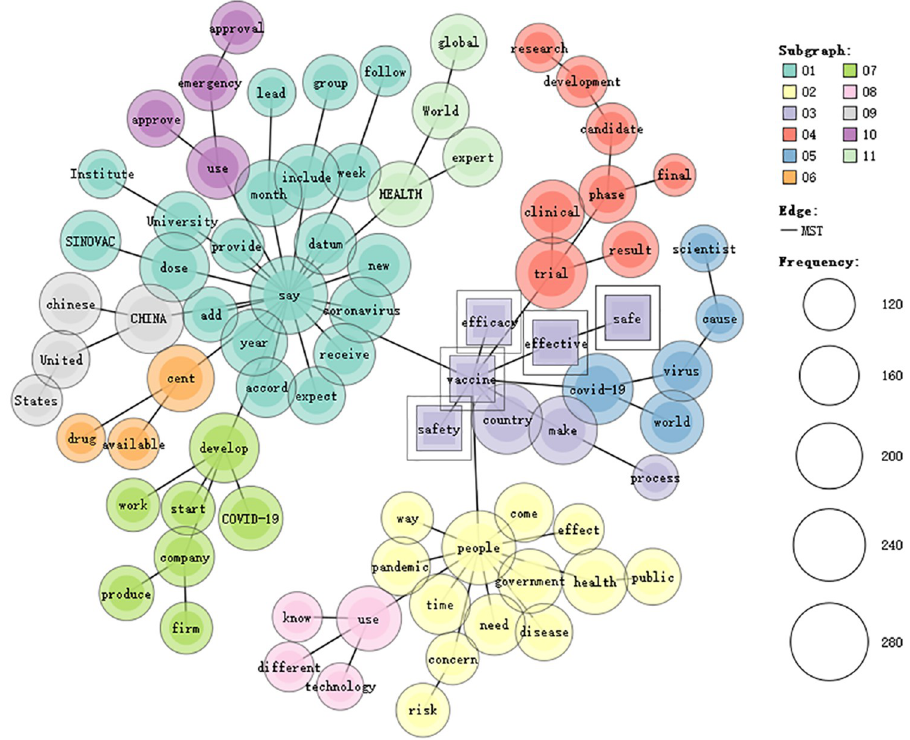
Fig 3. Co-occurrence network of the five keywords in